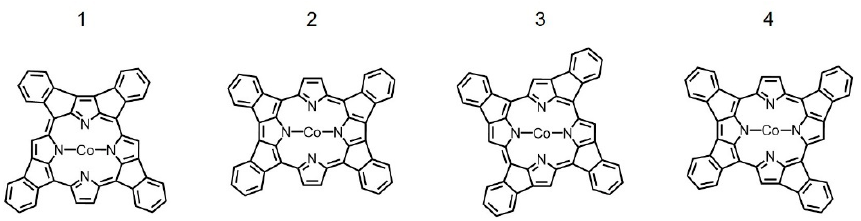
Figure A1. Four structural isomers of the DHC products of Co(TAP) on Au(111).